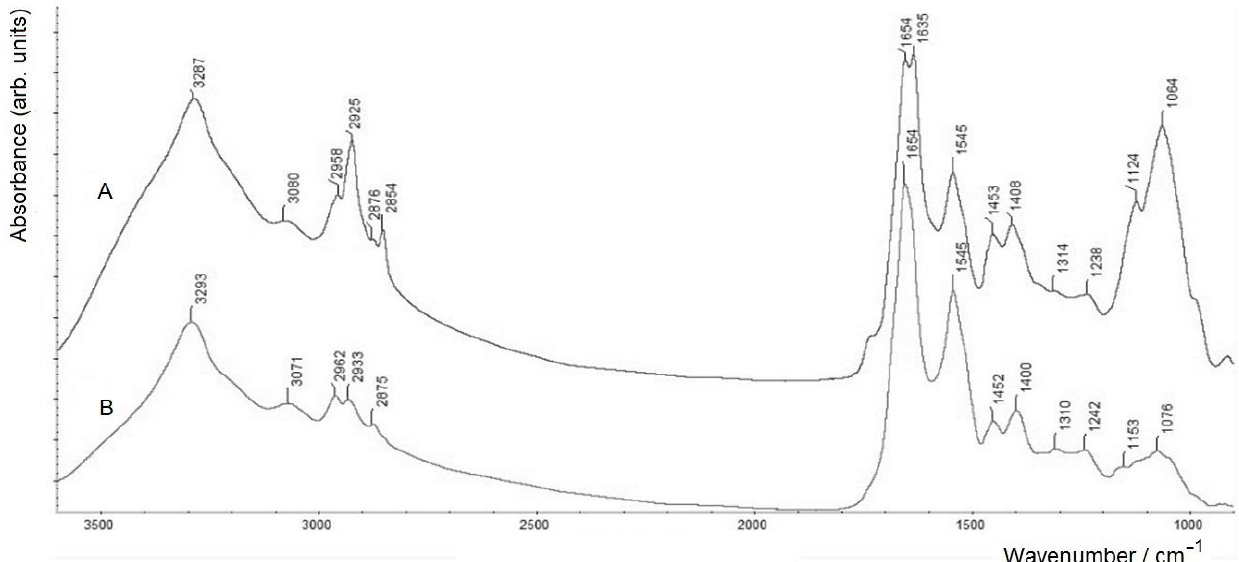
Figure 3. FTIR spectra of A. baldaniorum Sp245 biofilm matrix components BM1 ( A ) and BM2 ( B ) obtained by separating the crude biofilm matrix (sample BM) on a column with a Sepharose CL-6B carrier (measured in the transmission mode on a ZnSe glass disc).